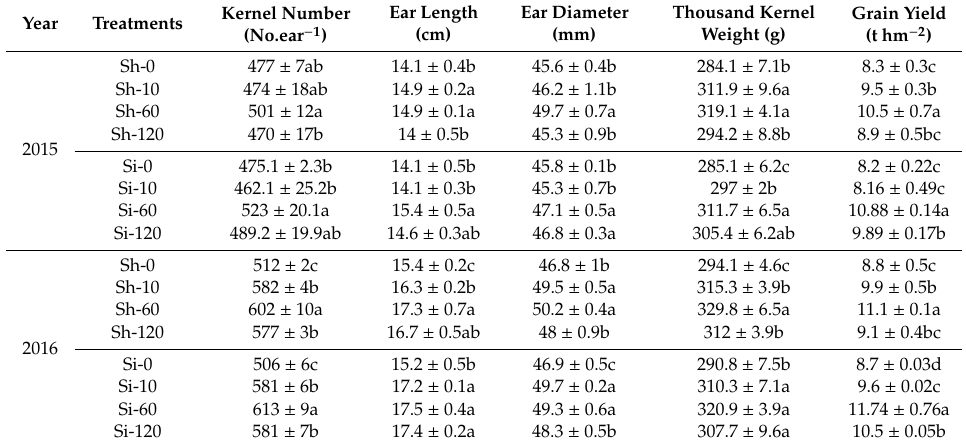
Table 2. E ff ects of GA 4 + 7 on ear length (cm), ear diameter (mm), kernels ear − 1 , thousand grain weight (g), and grain yield (t hm − 2 ) of maize in